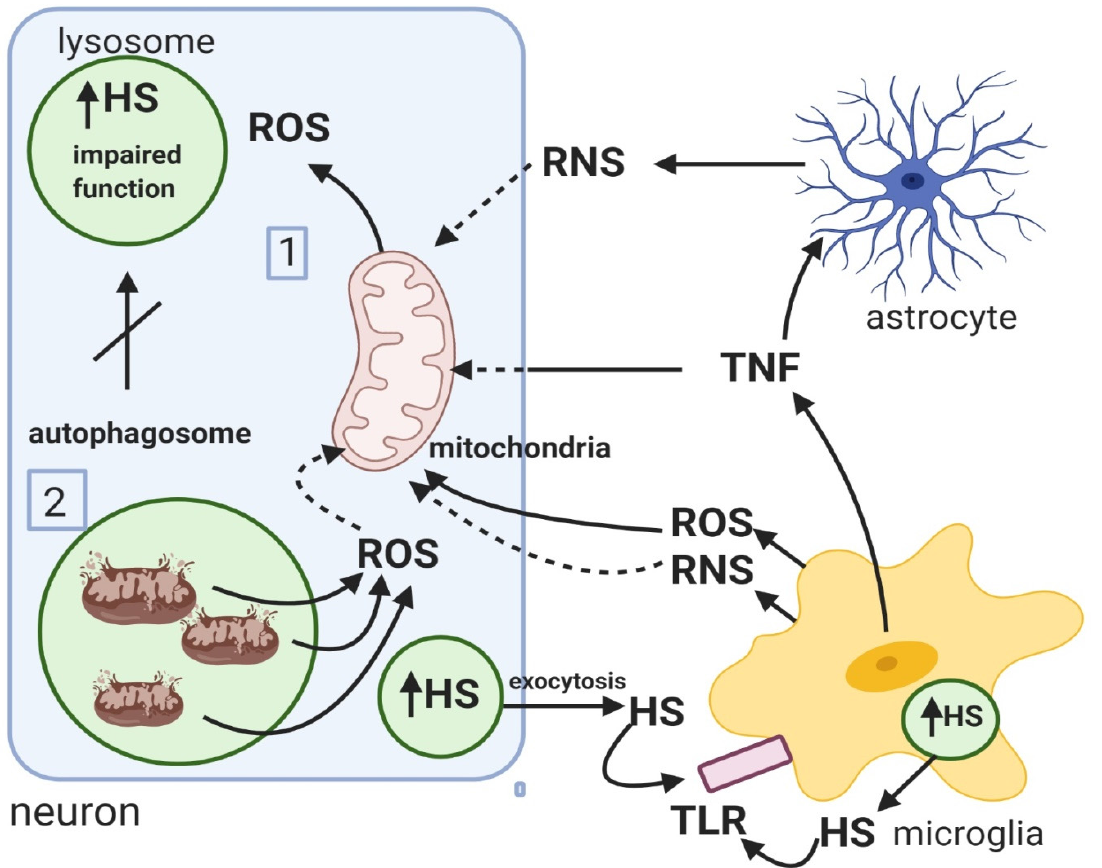
Figure 4. Putative mechanisms responsible for mitochondrial dysfunction in Mucopolysaccharidosis. HS: Heparin sulphate. MRC: Mitochondrial respiratory chain. ROS: Reactive oxygen species. RNS: Reactive nitrogen species. TNF: Cytokine.